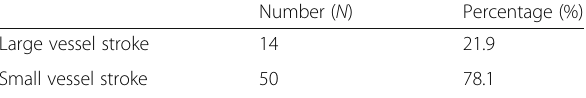
Table 6 Percentage of large versus small vessel stroke according to TOAST criteria among patients